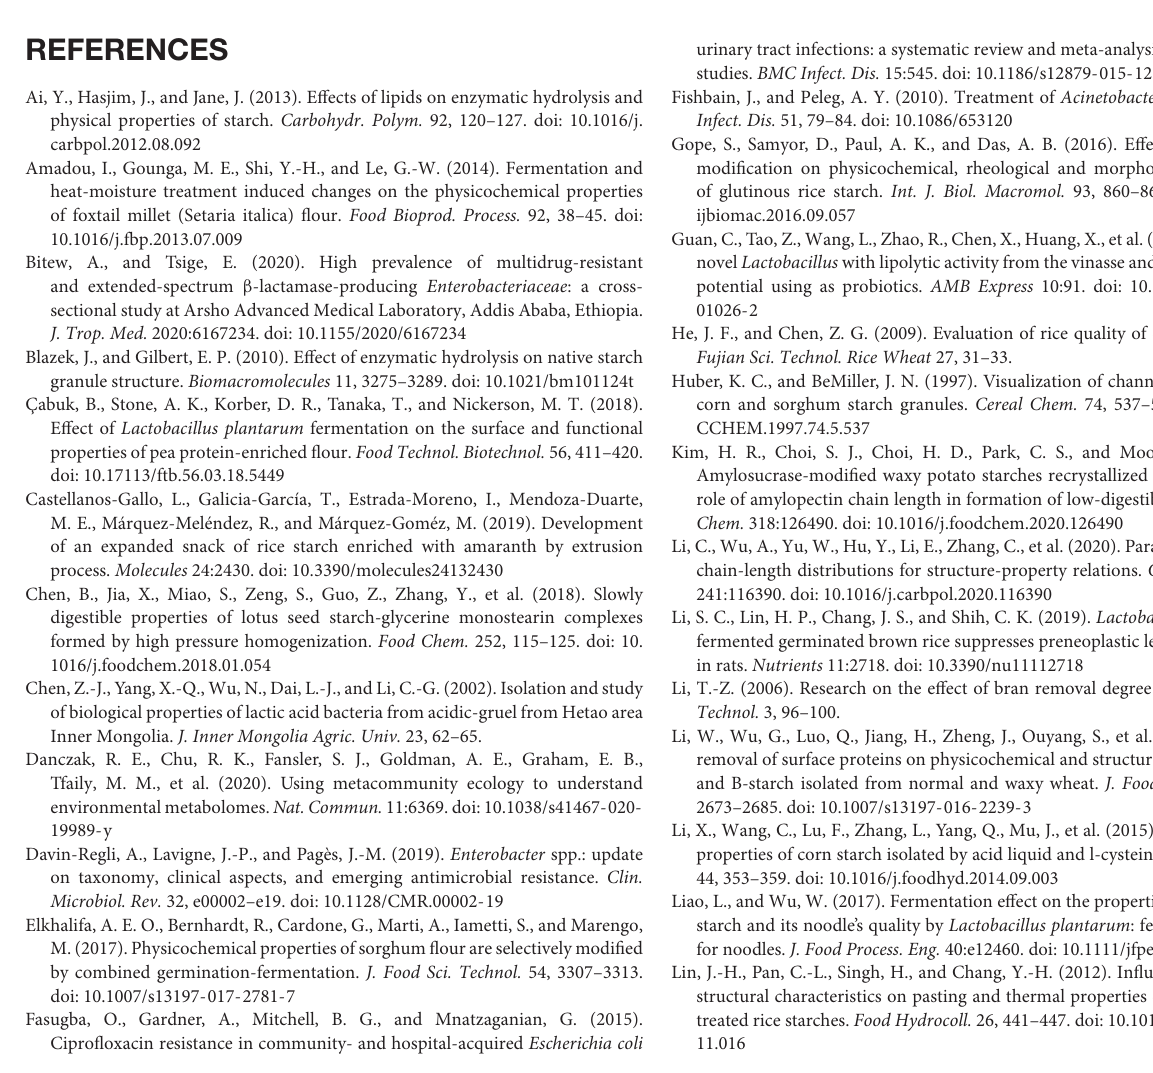
Supplementary Figure 1 | Production of sour porridge by natural fermentation. Supplementary Figure 2 | pH of sour porridge. pH change of sour porridge during 1–7 days of fermentation. Supplementary Figure 3 | Scanning electron micrograph of natural and fermented starch granules. (A) Natural starch granules (10,000 × ). (B) Fermented starch granules (10,000 × ). Supplementary Table 1 | Acid producing and morphological properties of selected lactic acid